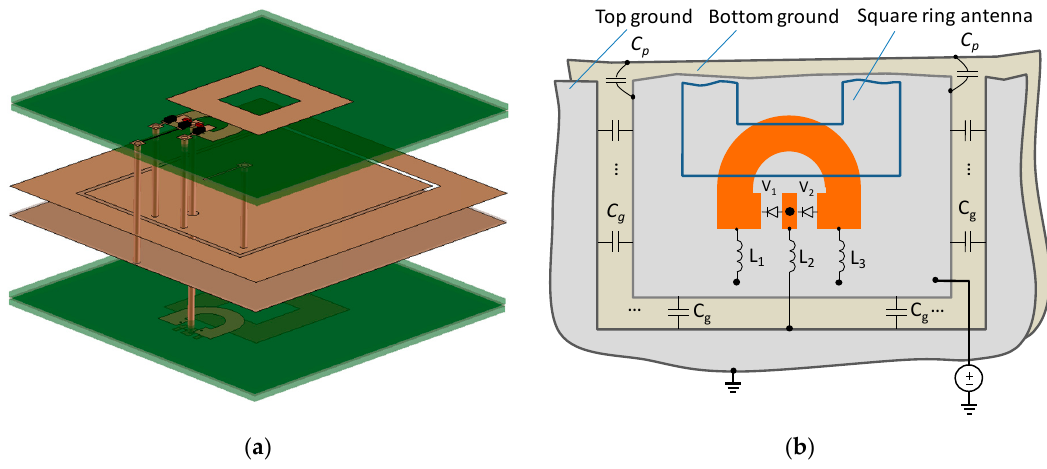
Figure 3. The proposed reconfigurable 1-bit unit cell structure ( a ), DC biasing network design of the unit-cell ( b ).